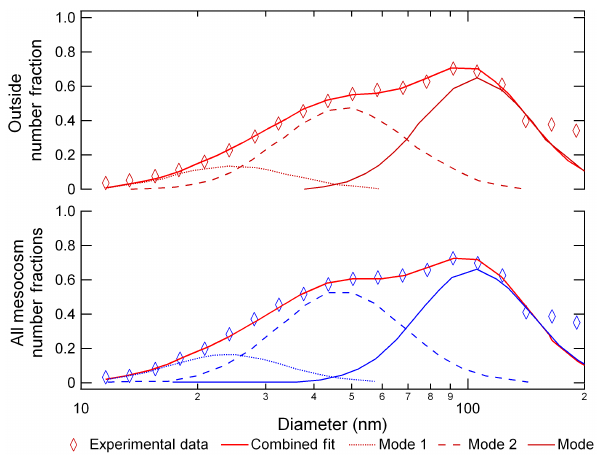
Figure 2. Average size distributions of the outside water and all mesocosms (A, B and C) at both supersaturations (SS = 0.30 and 0.15%) used in this study. The mesocosms are fit with three differ- ent log-normal